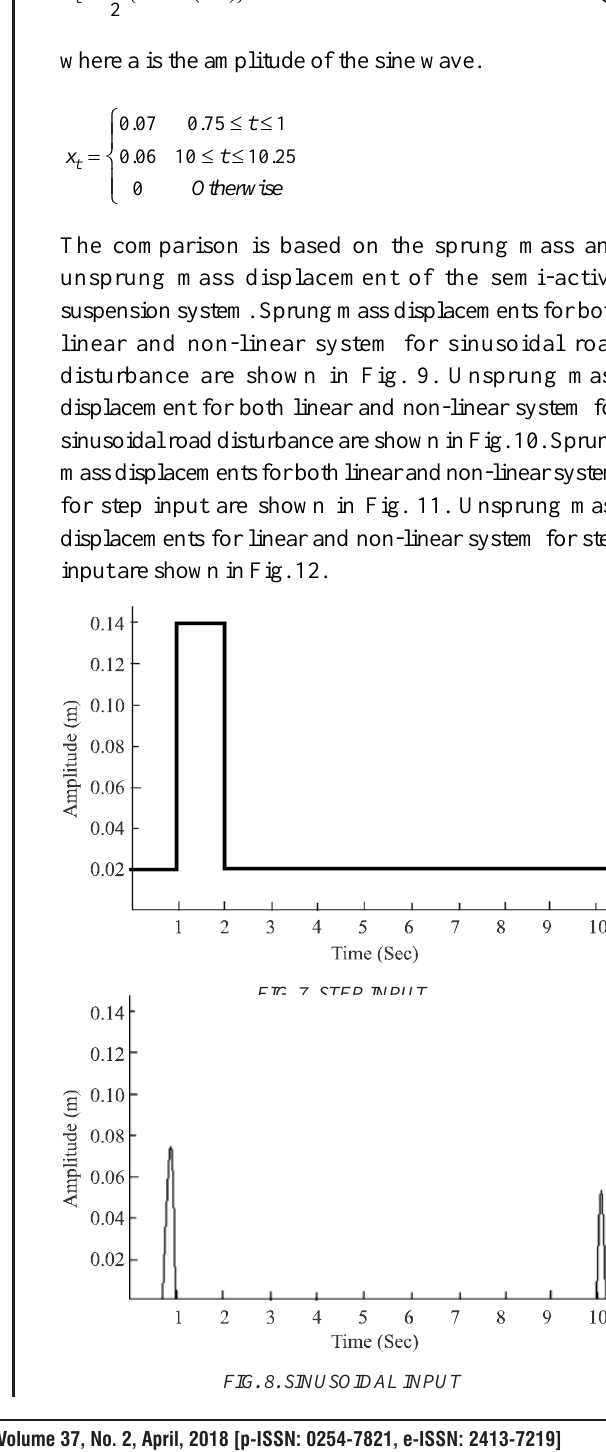
FIG. 6. SIMULINK SUSPENSION DISPLACEMENT RESPONSE